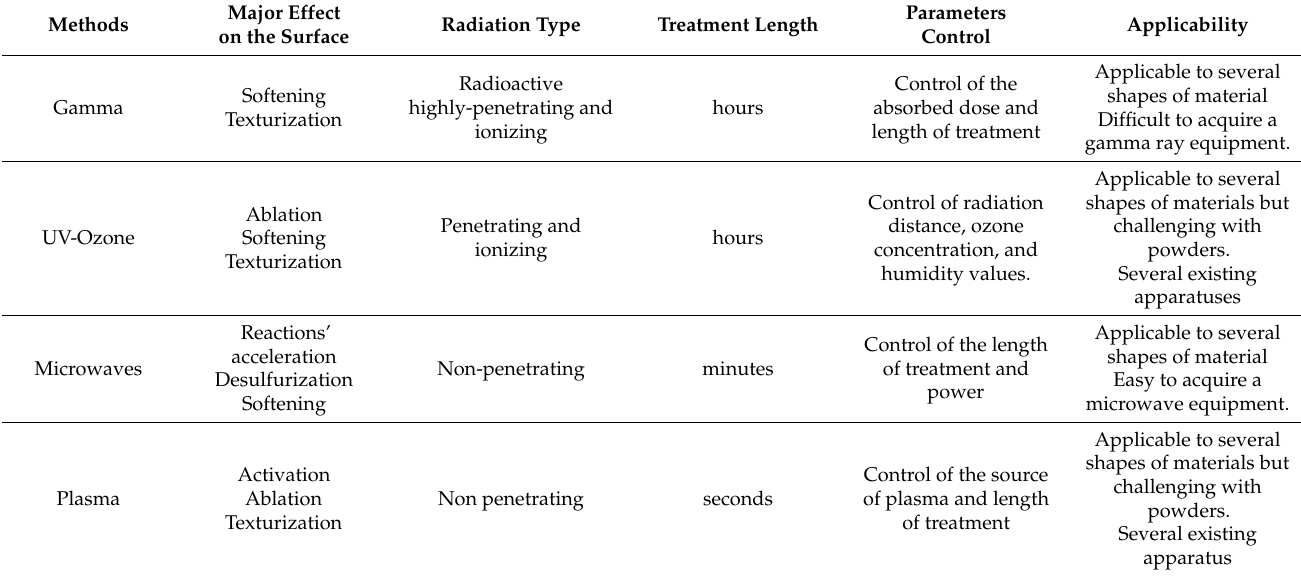
Table 5. Comparison between main physical surface treatment